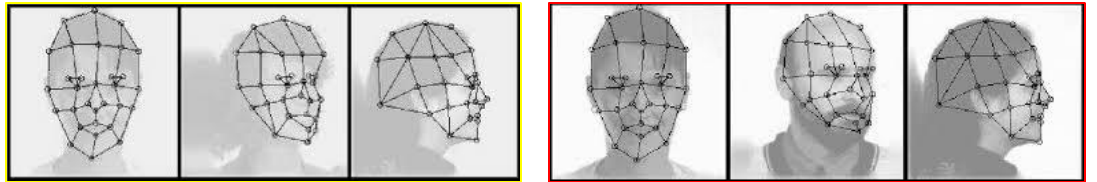
Figure 20. Example of extraction of landmarks using the elastic bunch graph-matching (EBGM) algorithm.